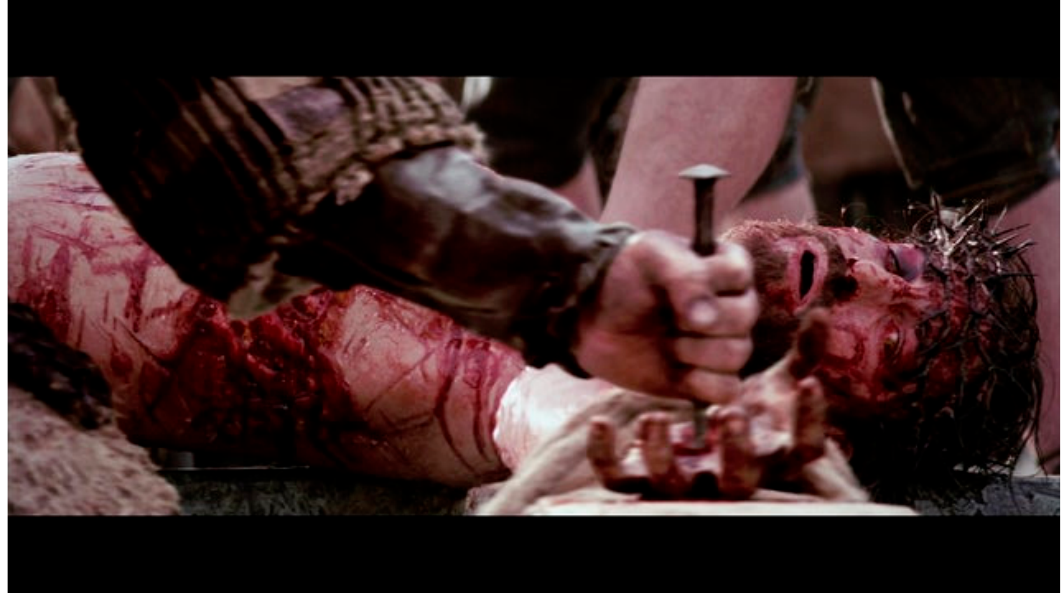
Figure 7. Movie still from The Passion of the Christ (2004) showing the crucifixion. Figure 8. Movie still from The Passion of the Christ (2004) showing the